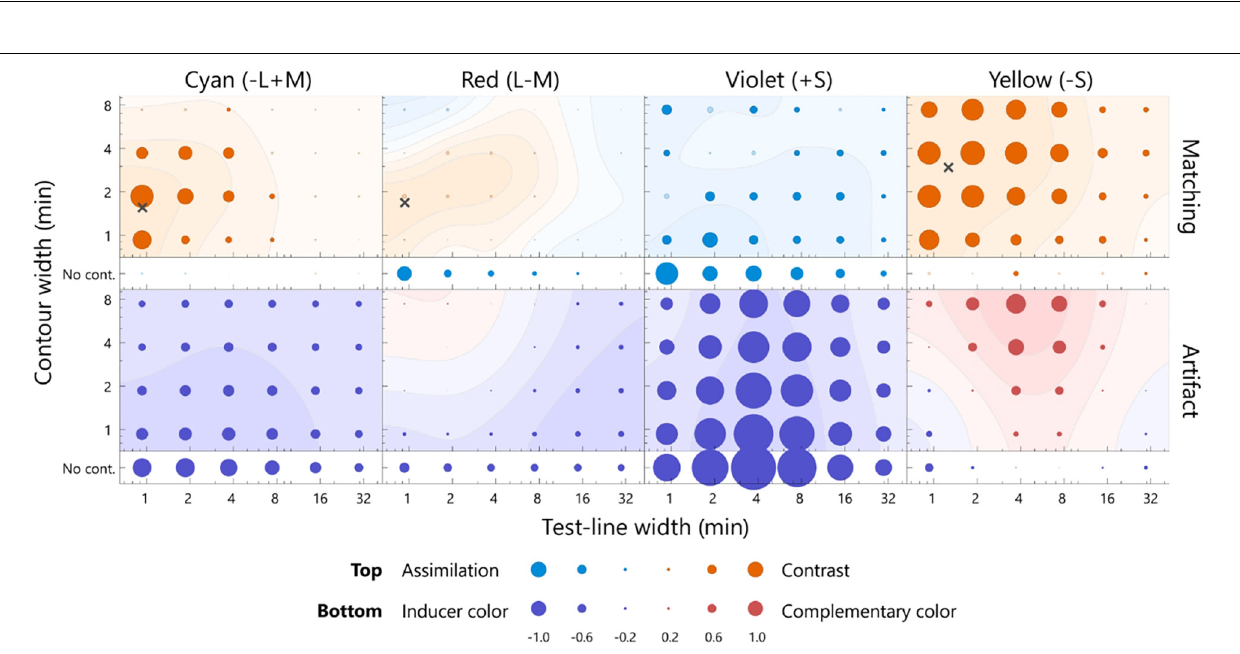
FIGURE 4 | The averaged matching across all the participants (top row) and the estimated artifacts (bottom row) for the pale test line. The chromaticities of the inducers from left to right was cyan, red, violet, and yellow. The horizontal axis indicates the width of the test line, and the vertical axis indicates the width of the contour. The diameter of each bubble indicates the magnitude of the color shift. The actual values for the diameters are below the axis label. The warm colored bubbles indicate the shift away from the inducer, and the cool colored bubbles indicate the shift toward the inducer. The filled bubbles represent a significant difference from zero ( p < 0.05, sign test). The color shift was calculated on the l -axis for the cyan and red inducer, s -axis for the violet and yellow inducer, and normalized by the inducer chromaticity (see section “Analysis”). A contour map represents smoothed data based on a two-dimensional Gaussian filter [sigma = log(1.5) for both the horizontal and vertical axes]. The contour map was normalized with the largest positive value and visualized with 25% increments. The red and blue surfaces indicate a shift away from the inducer and toward the inducer, respectively. The points of the widths inducing the largest color shift were estimated from smoothed data, as indicated by the cross marks. The actual values of the matching and artifact were shown in Supplementary Figure 2 .